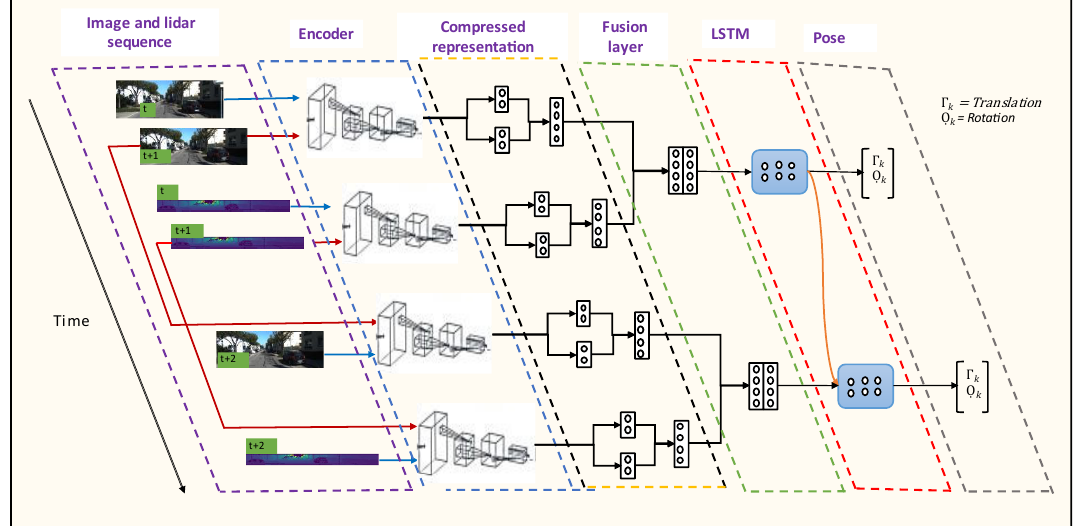
Figure 4. Architecture of the proposed end-to-end deep learning method.